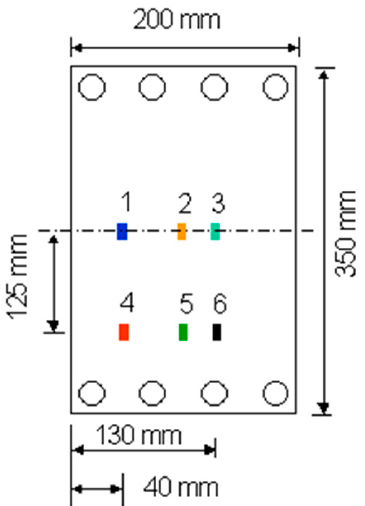
Figure 9. Schematic illustration of the location of the surface-mounted electrical resistance strain gauges that were used to monitor the strain on a steel plate when it was loaded on the flat-bed pre-stressing rig.